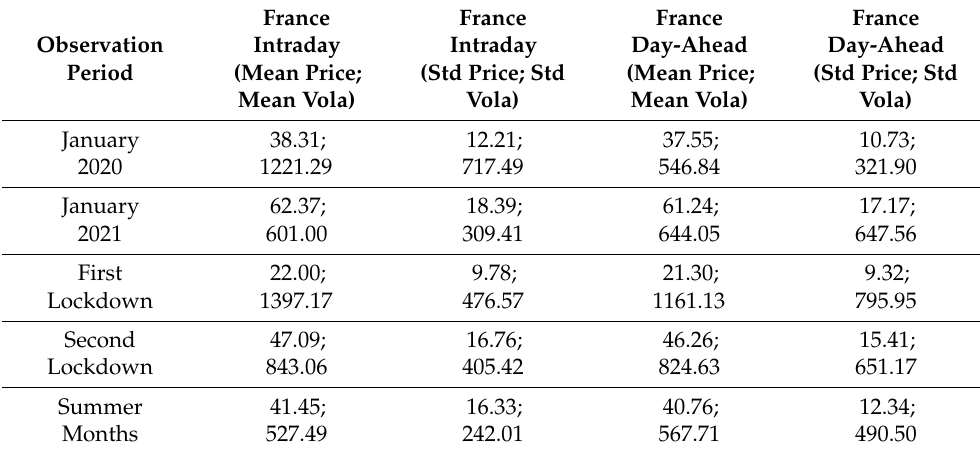
Table 5. General Statistics about French Prices and Volatilities in EUR.